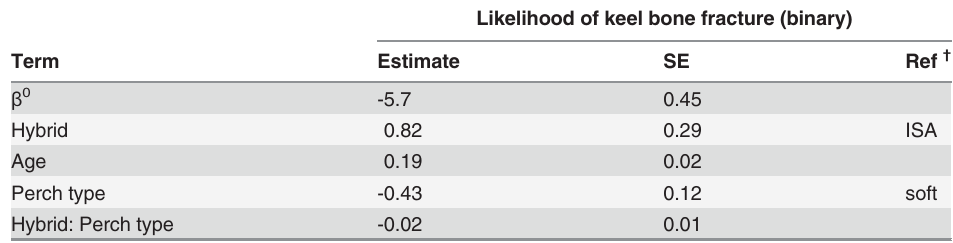
Table 2. Model output for the likelihood of keel bone fractures